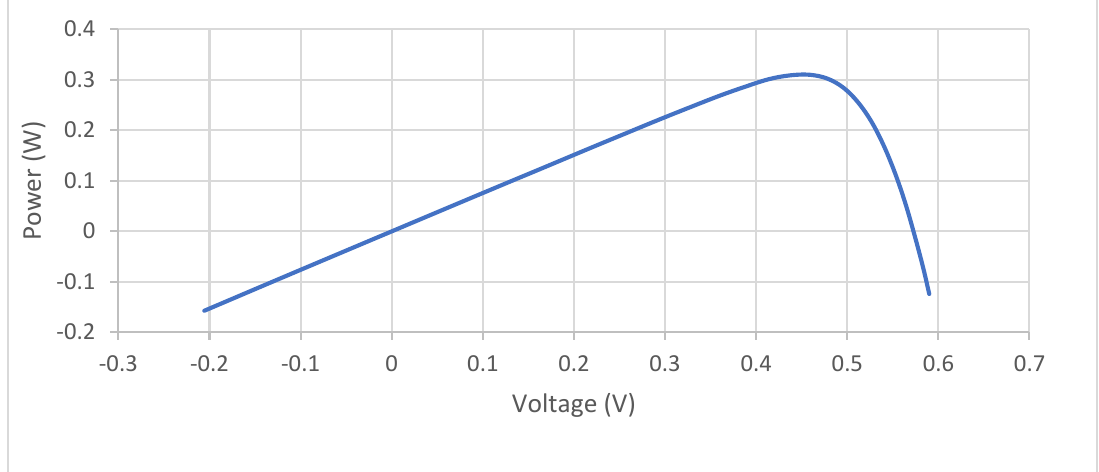
Figure 7. The P-V curve at standard temperature conditions. Table 3. Datasheet for two different types of PV cells.